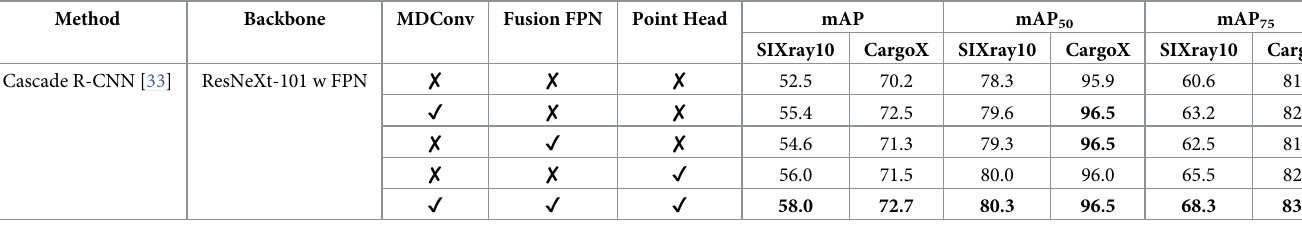
Table 6. Effect of each proposed module on the SIXray10 and CargoX